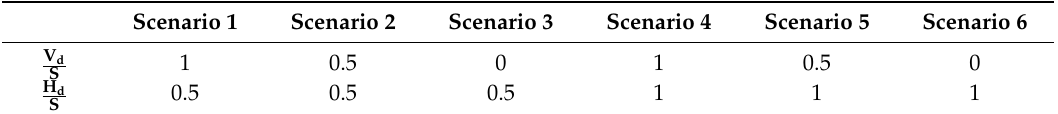
Figure 28. Contour lines of the threshold of failure for Scenario 5 end caps attached to the deck.